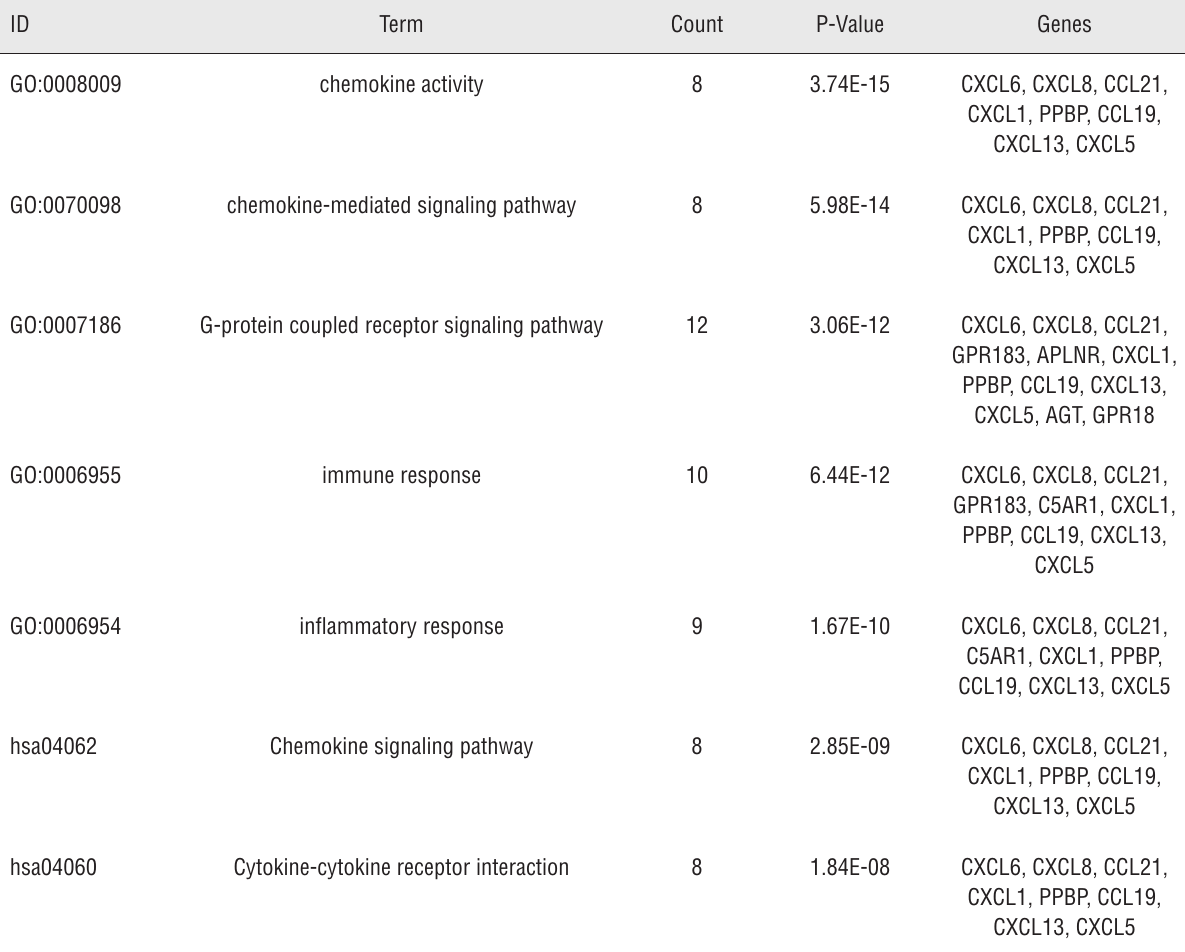
Table - 1 - The top 5 Enriched Gene Ontology (GO) and Kyoto Encyclopedia of Genes and Genomes (KEGG) of module 1 ID